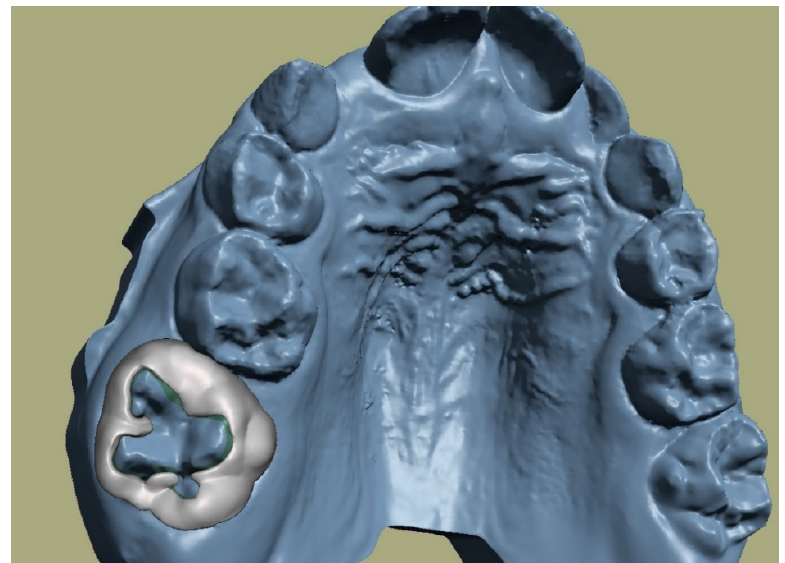
Figure 3. Designing a band in Meshmixer freeware. Standard band thickness 0.6 mm.